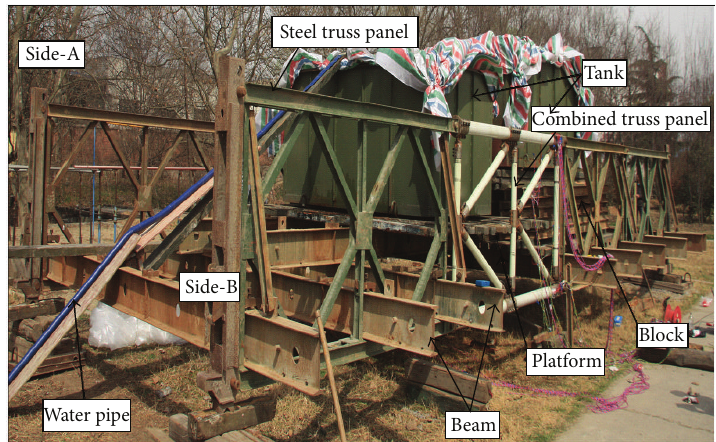
Figure 9: Static live loading mode of the structure.